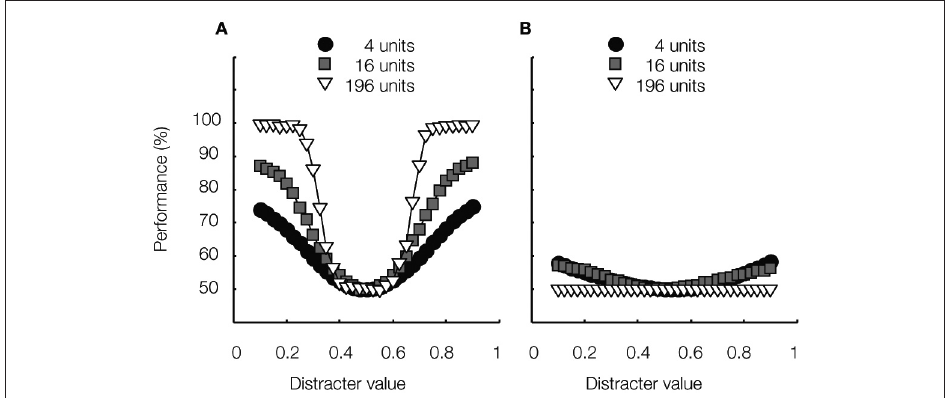
Figure 4 | The effect of pool size on classification performance. The average networks’ tuning function is shown in Figure 3C. Networks were further characterized by noisy neurons, inter-neuron variability in the 2-D tuning functions, and correlated noise. (A) Average classification performance is plotted as a function of distracter value for three different pool sizes, consisting of 4, 16 and 196 units, respectively. The test stimuli’s location on the irrelevant dimension was identical to the training situation. Thus, these data express the selectivity of the considered networks. The smooth shape of the curves shows that the classifier can interpolate between stimuli encountered during training. (B) Same as (A) for the maximal test-training difference illustrated in Figure 3A; thus, these data express the tolerance of the considered networks. The large difference with the data shown in (A) shows that the classifier cannot extrapolate from stimuli encountered during training. Similar results were shown in Goris and Op de Beeck (2009).